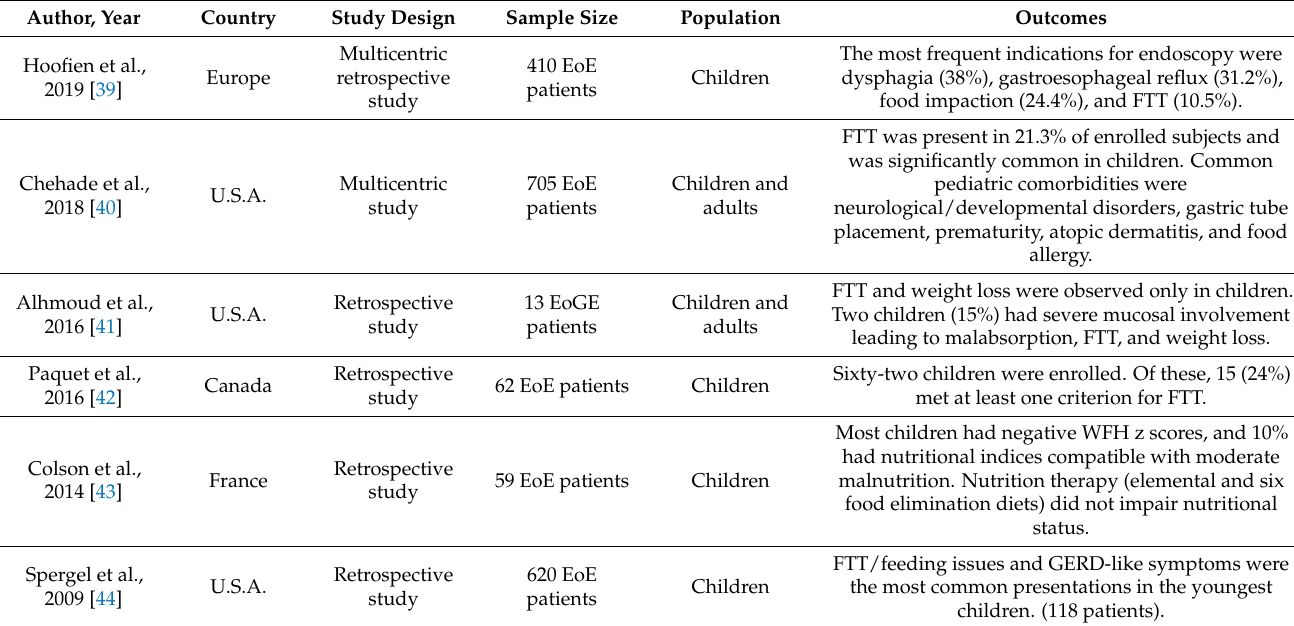
Table 3. Studies reporting underweight and failure to thrive in children and adult patients with